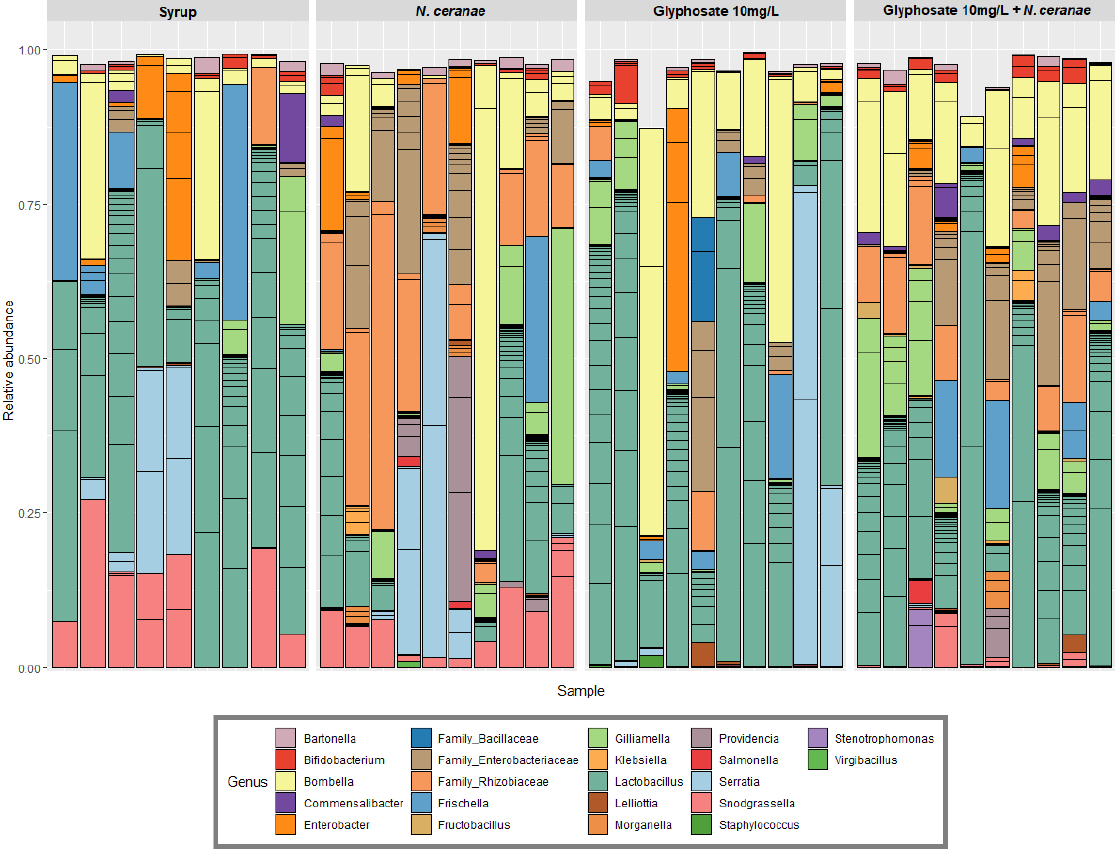
Figure 1. Relative abundance of different bacterial genera of the honey bee gut bacterial community subjected to seven days of chronic exposure to glyphosate in sucrose syrup (10 mg/L), N. ceranae infection (100,000 spores/bee at day 0) and both stress factors combined. Ten honey bees per treatment (three/four bees per cage, from three independent cages) were individually analyzed.